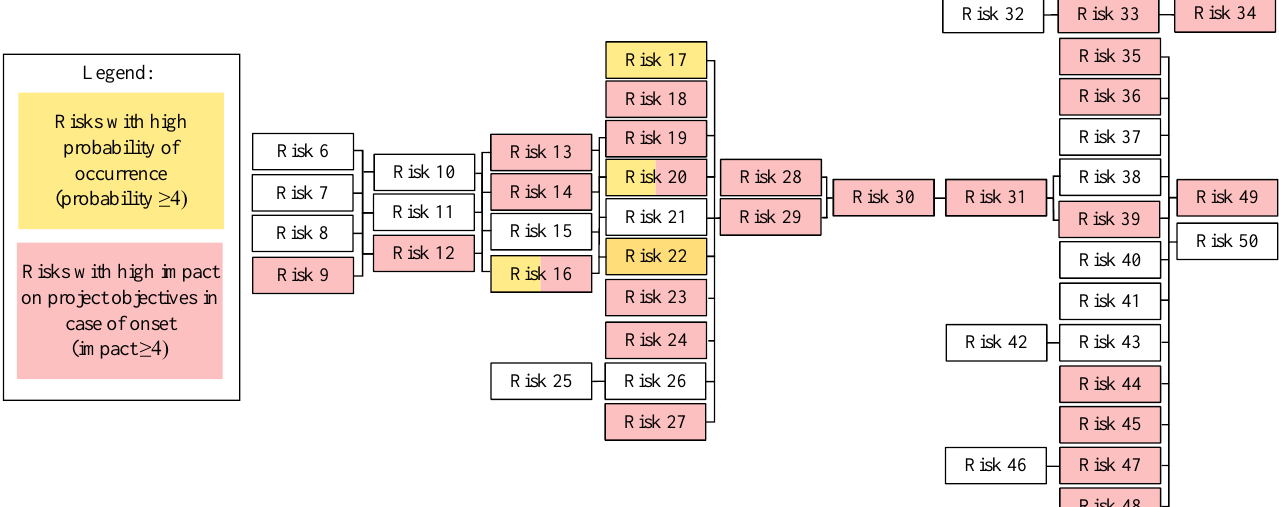
Figure 2. Model of cause-and-effect relationships for IT project compliance risks.